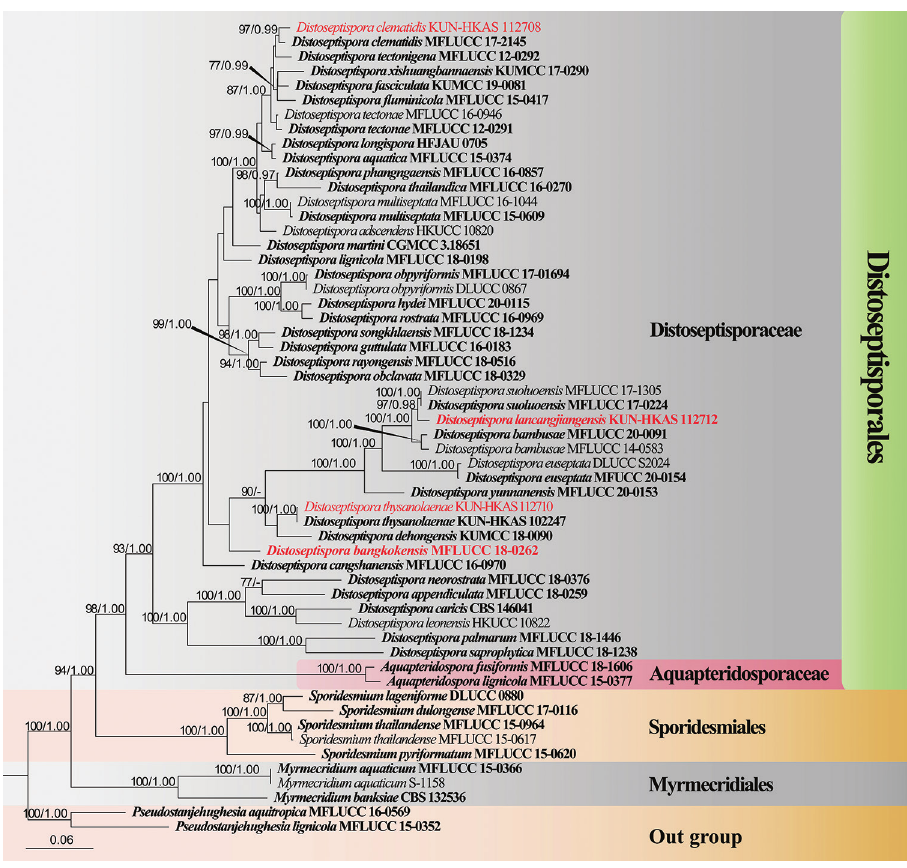
Figure 1. Maximum likelihood (ML) tree is based on combined of LSU, ITS, SSU, TEF1- α , and RPB2 sequence data. Bootstrap support values with an ML greater than 70% and Bayesian posterior probabili- ties (PP) greater than 0.97 given above the nodes, shown as “ML/PP”. The tree is rooted with Pseudostanje- hughesia aquitropica (MFLUCC 16-0569) and P. lignicla (MFLUCC 15-0352). New species are indicated in red and type strains are in